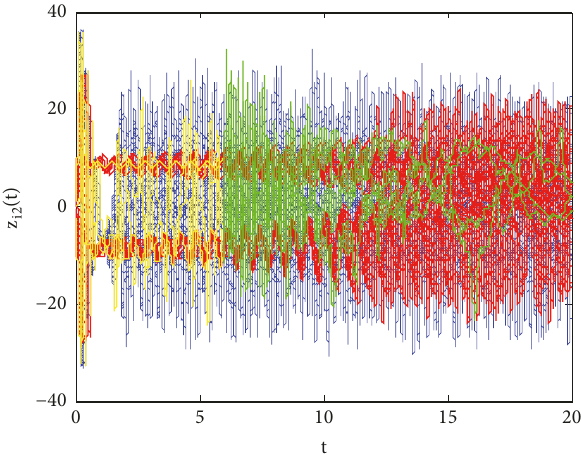
Figure 9: (Color online) Less node control community network 𝑧 (𝑡) with 𝑡 . 𝑖2